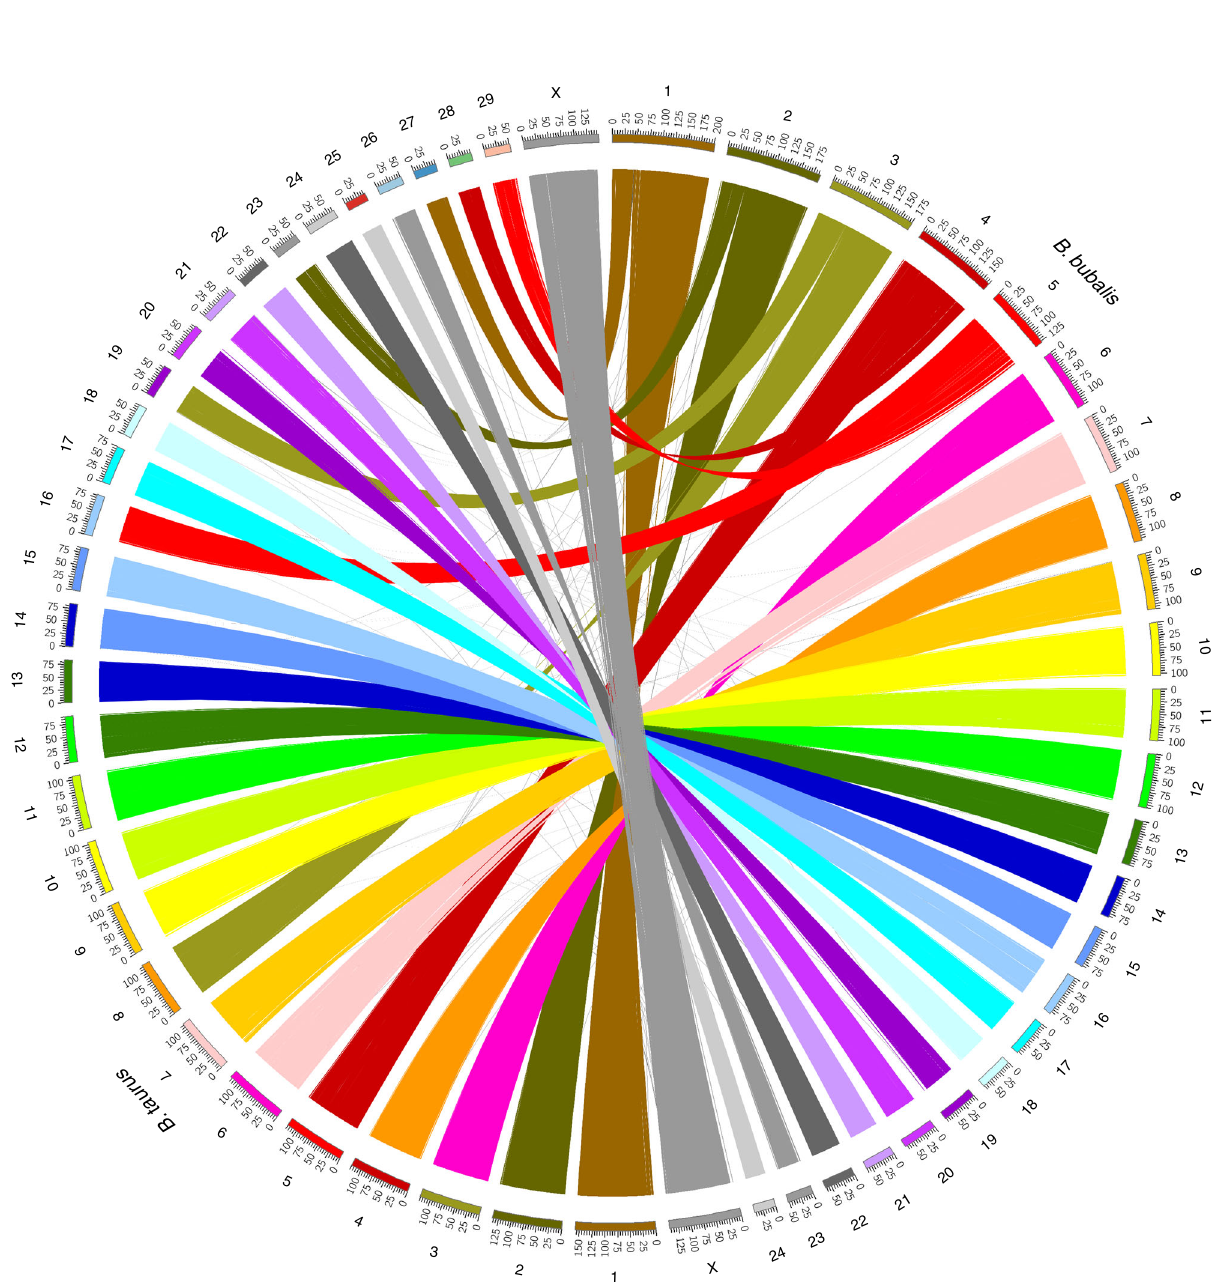
Fig. 2 A circos plot of B. bubalis chromosome mapping to B. taurus . Chromosome 1 – 5 in B. bubalis are sub-metacentric and clear mapping to the expected homologous B. taurus (UMD3.1) chromosomes is found. Conservation of synteny of all B. bubalis chromosomes to B. taurus matched the whole-genome RH map